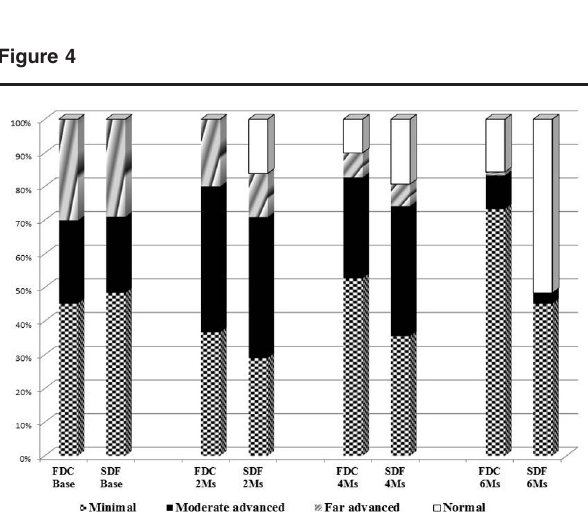
Changes in renal function, uric acid, and ESR during course of treatment in both groups.